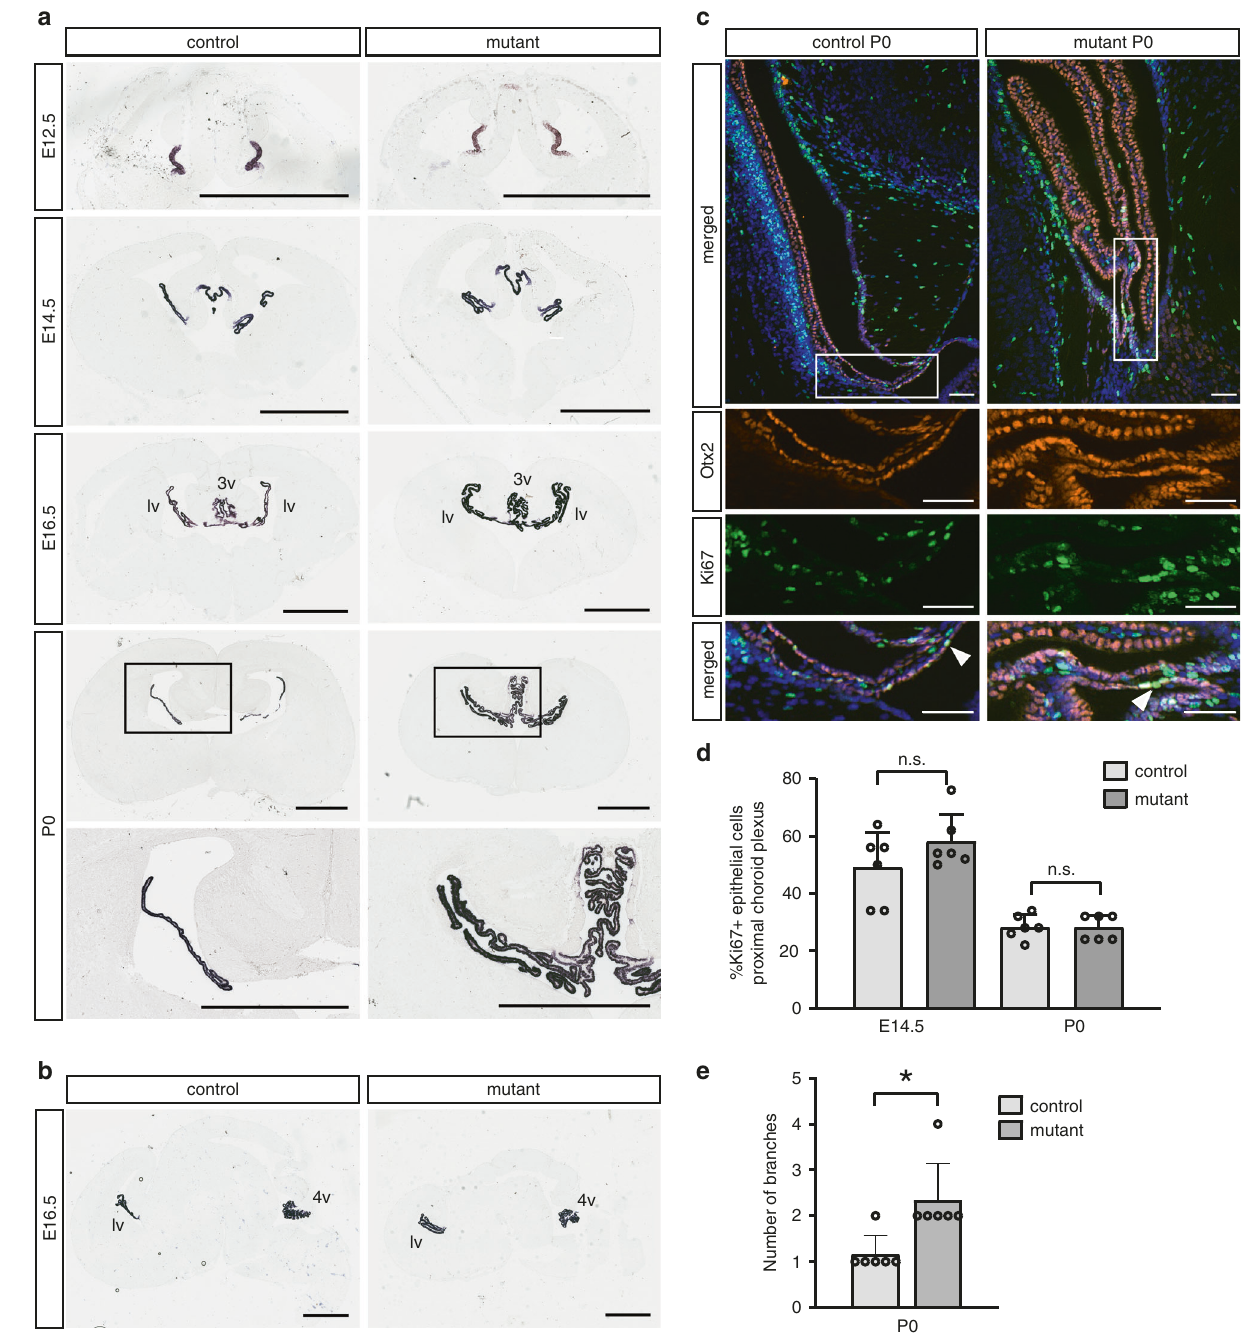
Fig. 5 Mutant mice develop a larger mass of Ttr -expressing choroid plexus (CP). a , b Ttr expression detected by in situ hybridizations. a Coronal brain sections at the level of the lateral to third ventricle junction from different developmental stages. Note the increased number of CP tissue folds in the lateral and third ventricles of the P0 mutant brains. Enlarged regions of P0 sections are shown at the bottom. b Sagittal sections from E16.5 animals. Scale bars ( a , b ): 1 mm. c Immunostainings of P0 coronal brain sections containing the site of CP attachment to the ventricle wall (proximal CP). Otx2-positive CP epithelial cells (red), Ki67-positive cells (green), and DAPI-positive nuclei (blue) are shown. Lower panels display higher magni fi cations of the proximal CP region framed in the upper panel. Arrowheads point to Ki67-positive CP epithelial cells. Scale bars: 100 µ m. d Percentage of Ki67-positive cells present in the proximal Otx2-positive CP tissue determined in E14.5 and P0 animals. The most proximal 50 cells starting from the attachment point of the CP were analyzed. The right and the left lateral ventricle of three control and three mutant animals of the same litter were investigated (six choroid plexi per group). Bars display the mean with standard deviations. p values (unpaired two-tailed Student ’ s t test): n.s. not signi fi cant. e Number of branches in CP tissue of P0 animals. The right and the left lateral ventricle of three control and three mutant animals of the same litter were investigated (six choroid plexi per group). Bars display the mean with standard deviations. p values (unpaired two-tailed Student ’ s t test): * p ≤ 0.05. Source data are provided as a Source Data fi